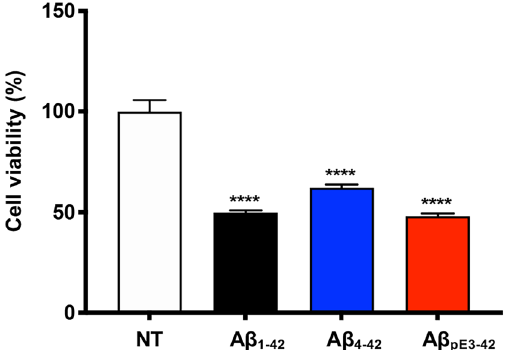
Figure 3. Cellular toxicity of synthesized Aβ pE3-42 peptide. Synthesized Aβ variants (Aβ 1-42 , Aβ 4-42 , Aβ pE3-42 ) were prepared and each of aggregated Aβ variant was treated in the cultured HT22 cell. After the treatment, the cell viability was measured utilizing MTT assay. Cell viability of Aβ variants (Aβ 1-42 , Aβ 4-42 , Aβ pE3-42 ) were statistically compared to non-treated group (4 groups, n = 3 per group). One-way ANOVA analysis followed by Bonferroni’s post-hoc comparison tests were performed in all statistical analyses (**** p < 0.0001). The error bars represent S.E.M. NT, Non-treated; Aβ 1-42 , Amyloid-β 1-42 ; Aβ 4-42 , Amyloid-β 4-42 ; Aβ pE3-42 , Pyroglutamate amyloid-β 3-42